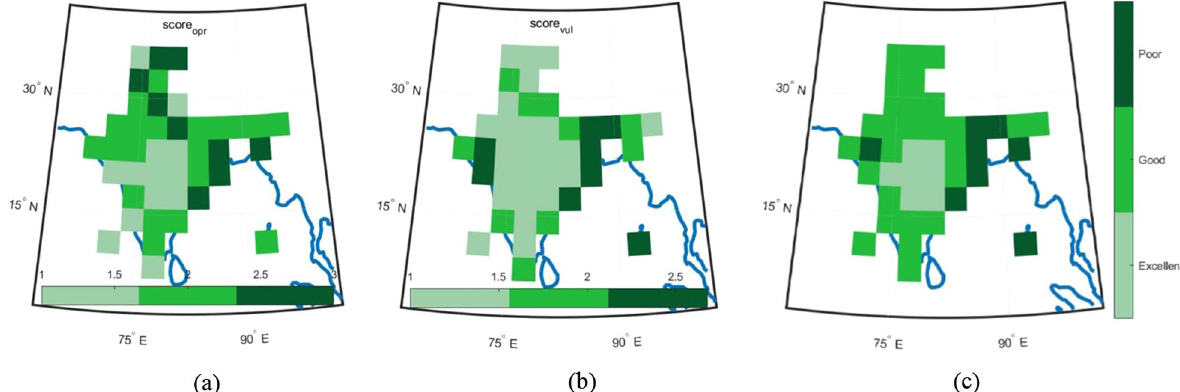
Fig. 9 a Scores for operationality; b scores for vulnerability; c categorization of study locations based on final scores for assessing the impact of environmental